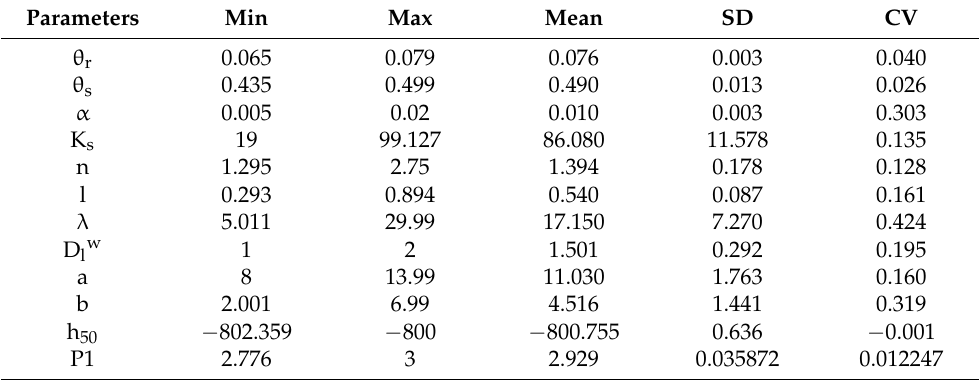
Table 6. Statistical indices of the model posterior distribution obtained from the M-H algorithm.